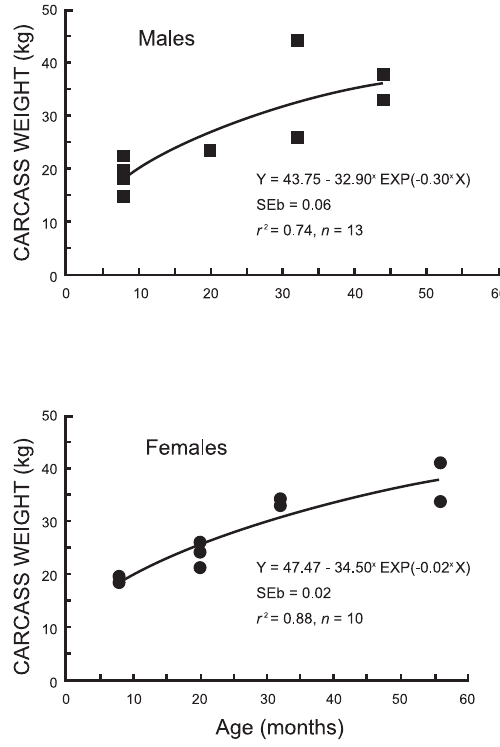
Fig. 3. Relationship between carcass weight and age (months) of free-ranging male and female rein- deer from Nunivak Island, Alaska, January,